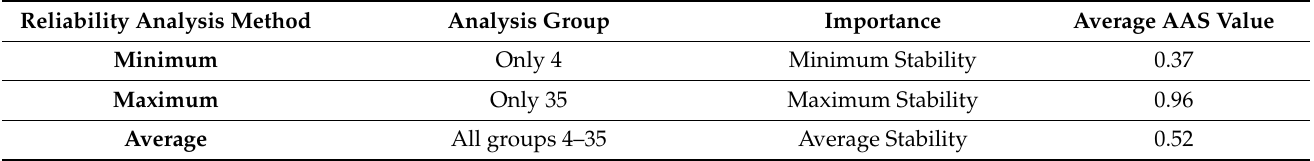
Figure 8. The overall reliability analysis. Table 7. The reliability analysis summary.